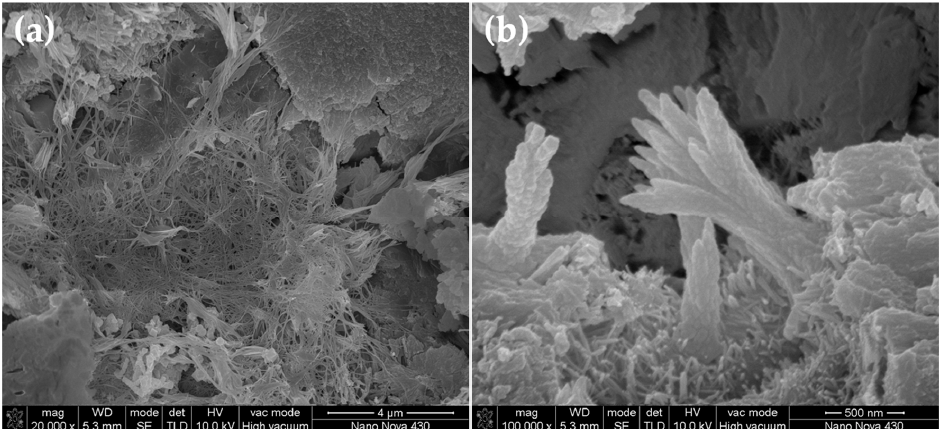
Figure 9. SEM images of fibrous-like and flower-like crystals in the cement paste with 0.05% bwoc GONSs: ( a ) a cluster of fibrous crystals and ( b ) some flower-like crystals found in the pore. Images Table 4. The chemical composites of cement hydration crystals. were taken using a FEI Nova NANOSEM 430 instrument operating at 10.0 kV. Table 4. The chemical composites of cement hydration crystals. Table 4. The chemical composites of cement hydration crystals. Figure 9a: fibrous-like crystals 20.59 12.91 52.07 14.43 Figure 9b: flower-like crystals Figure 9a: fibrous-like crystals Figure 9a: fibrous-like crystals Figure 9b: flower-like Figure 9b: flower-like crystals